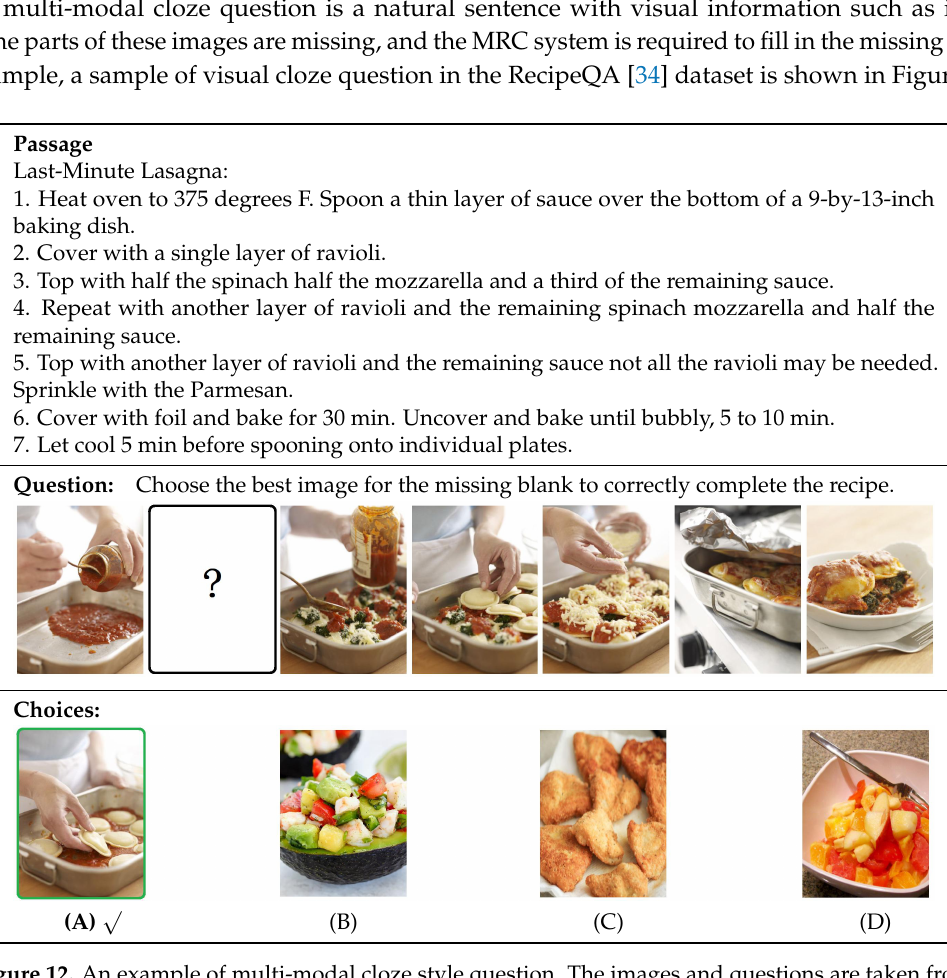
Figure 12. An example of multi-modal cloze style question. The images and questions are taken from the RecipeQA [34]